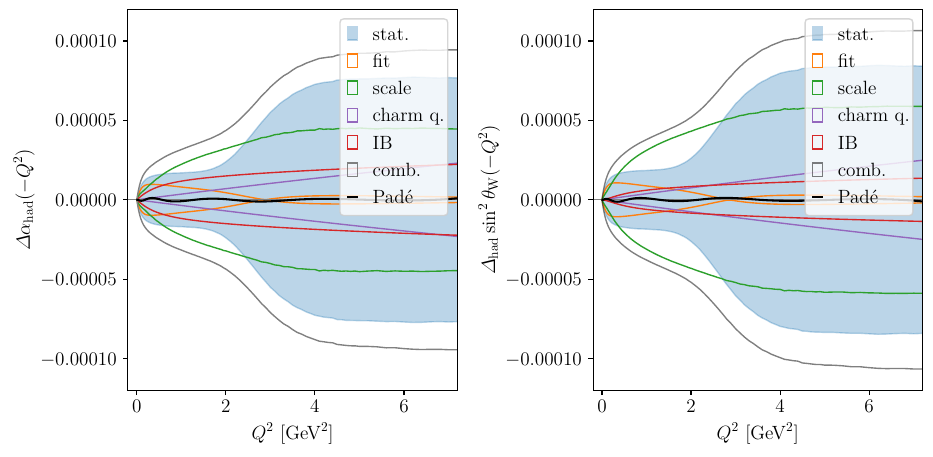
Figure 11 . The deviation of the rational approximation of ∆α had (left) and ∆ had sin 2 θ W (right) from the data, plotted as a function of Q 2 and compared to the statistical error (blue-shaded area) as well as different sources of systematic uncertainty: fit model (orange-bordered area), scale setting (green-bordered area) and isospin breaking (red-bordered area). The plots show that statistical (cid:0) (cid:1) errors increase when a term of O a 3 is added to the leading discretization effect of O model for Q & 2 . 5 GeV 2 . The gray lines represent the total